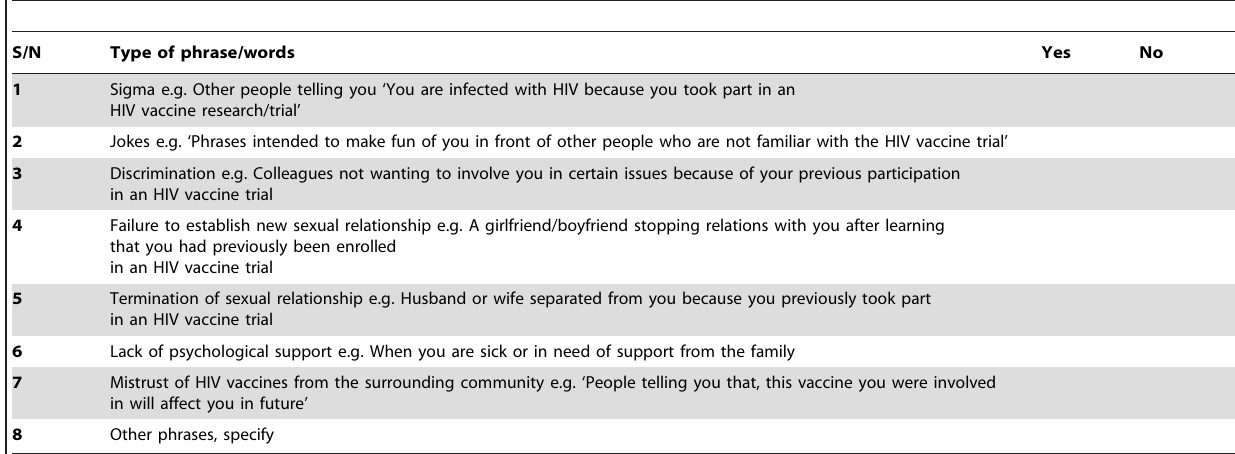
Table 2. Types of negative comments/reactions from other people (Insert tick [ ! ] in the appropriate box(s)).